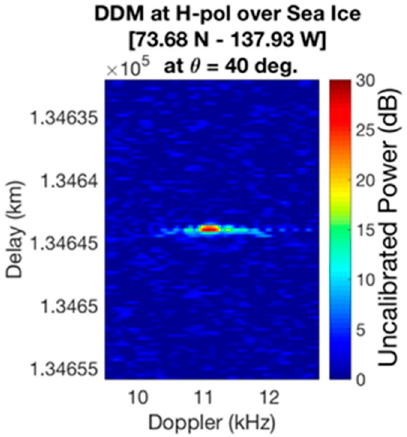
Figure 1. Example of a Soil Moisture Active Passive (SMAP)-Reflectometry (SMAP-R) measurement over the sea ice.